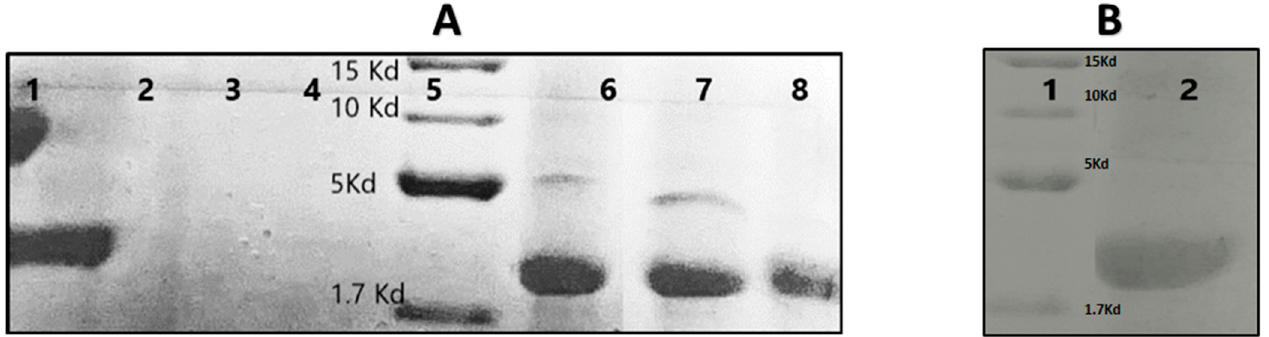
Figure 3. Tricine-SDS-PAGE analysis of Nisin with different treatments. A) Lane 1: Nisin (4 mg/mL);